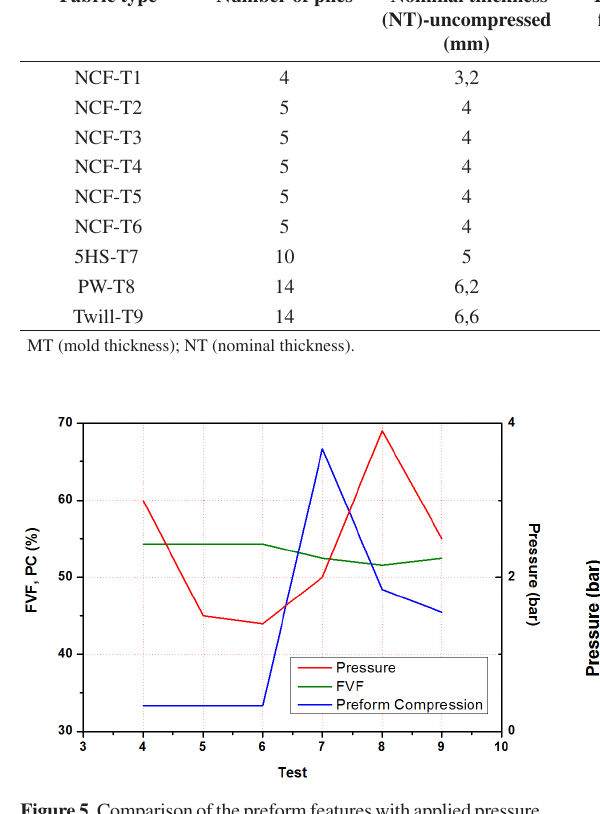
Table 1. Materials and manufacturing conditions. Fabric type